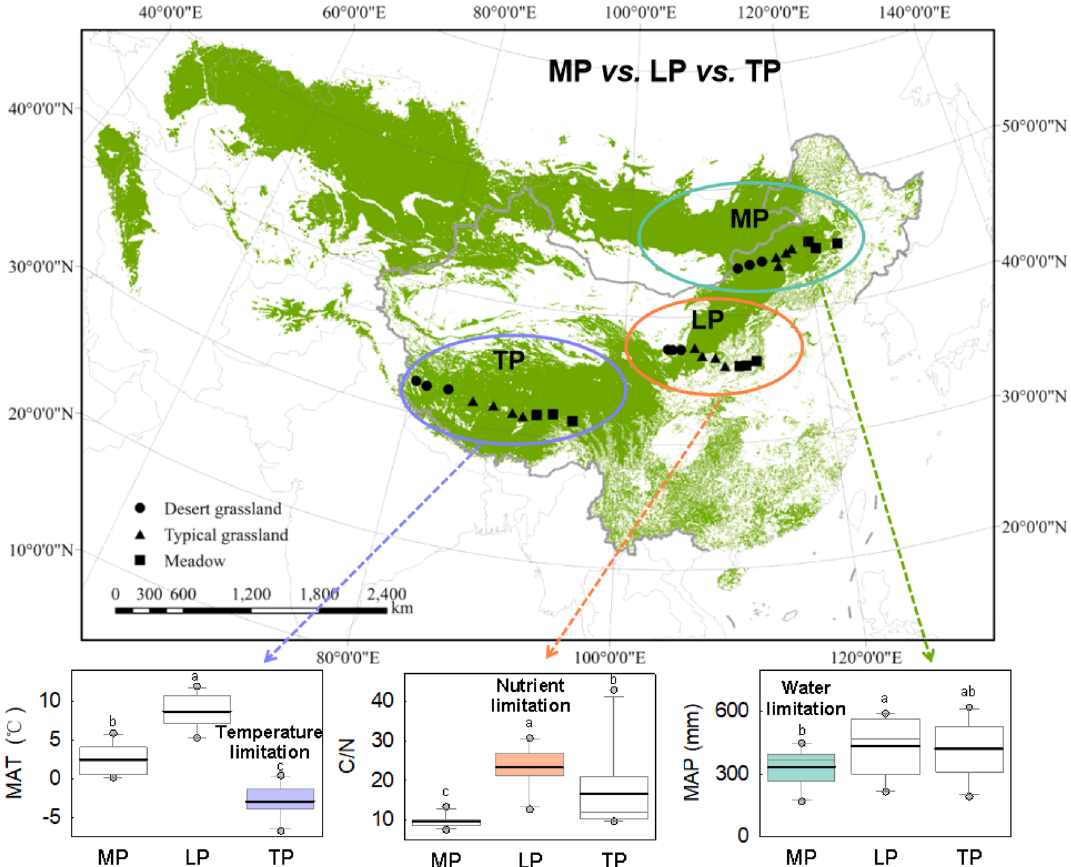
Figure 7. Experimental design and spatial distribution of sampling sites. We established three comparative transects in the Mongolia Plateau (MP), Loess Plateau (LP), and Tibetan Plateau (TP). These regions have different primary limitations for plant growth, representing meadow, typical grassland, and desert grassland, respectively. These comparative transects are expected to provide information on spatial variation in leaf water content (LWC) and the underlying mechanisms that influence it. The land cover data used in our study were collected from the Land Cover Type Climate Modelling Grid (CMG) product (MCD12C1) in 2012 (LP DAAC; https:// lpdaac. usgs. gov). Figures were done by ERSI ArcGIS software (Version 10.1; Redlands, CA,